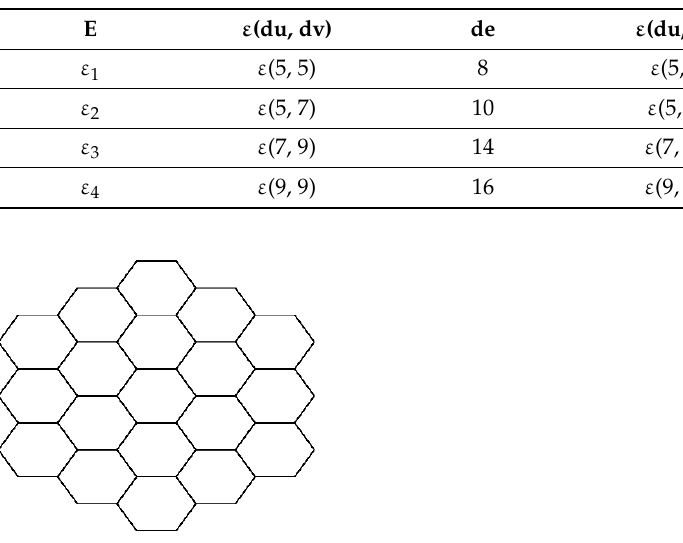
Figure 7. Honeycomb network with n number of cells (HC n ).